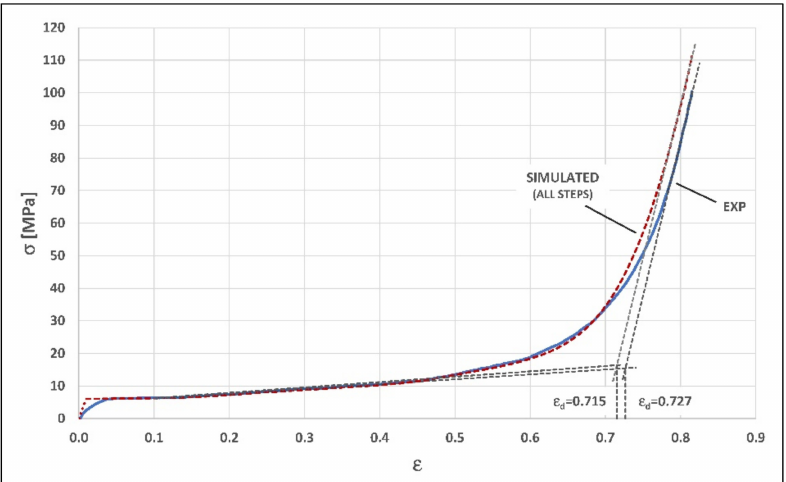
Figure 12. Comparison between experimental curve and simulated curve (envelop of results from all compression steps morphology, 0.4% TiH 2